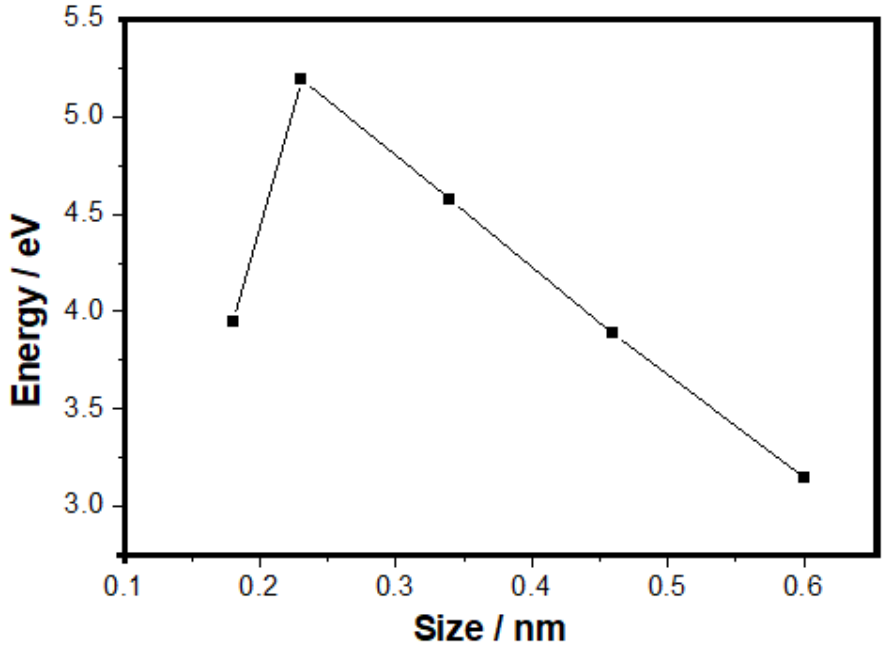
Figure 8. Energy change of bandgap with decreasing diameter of Si NW near monoatomic line.